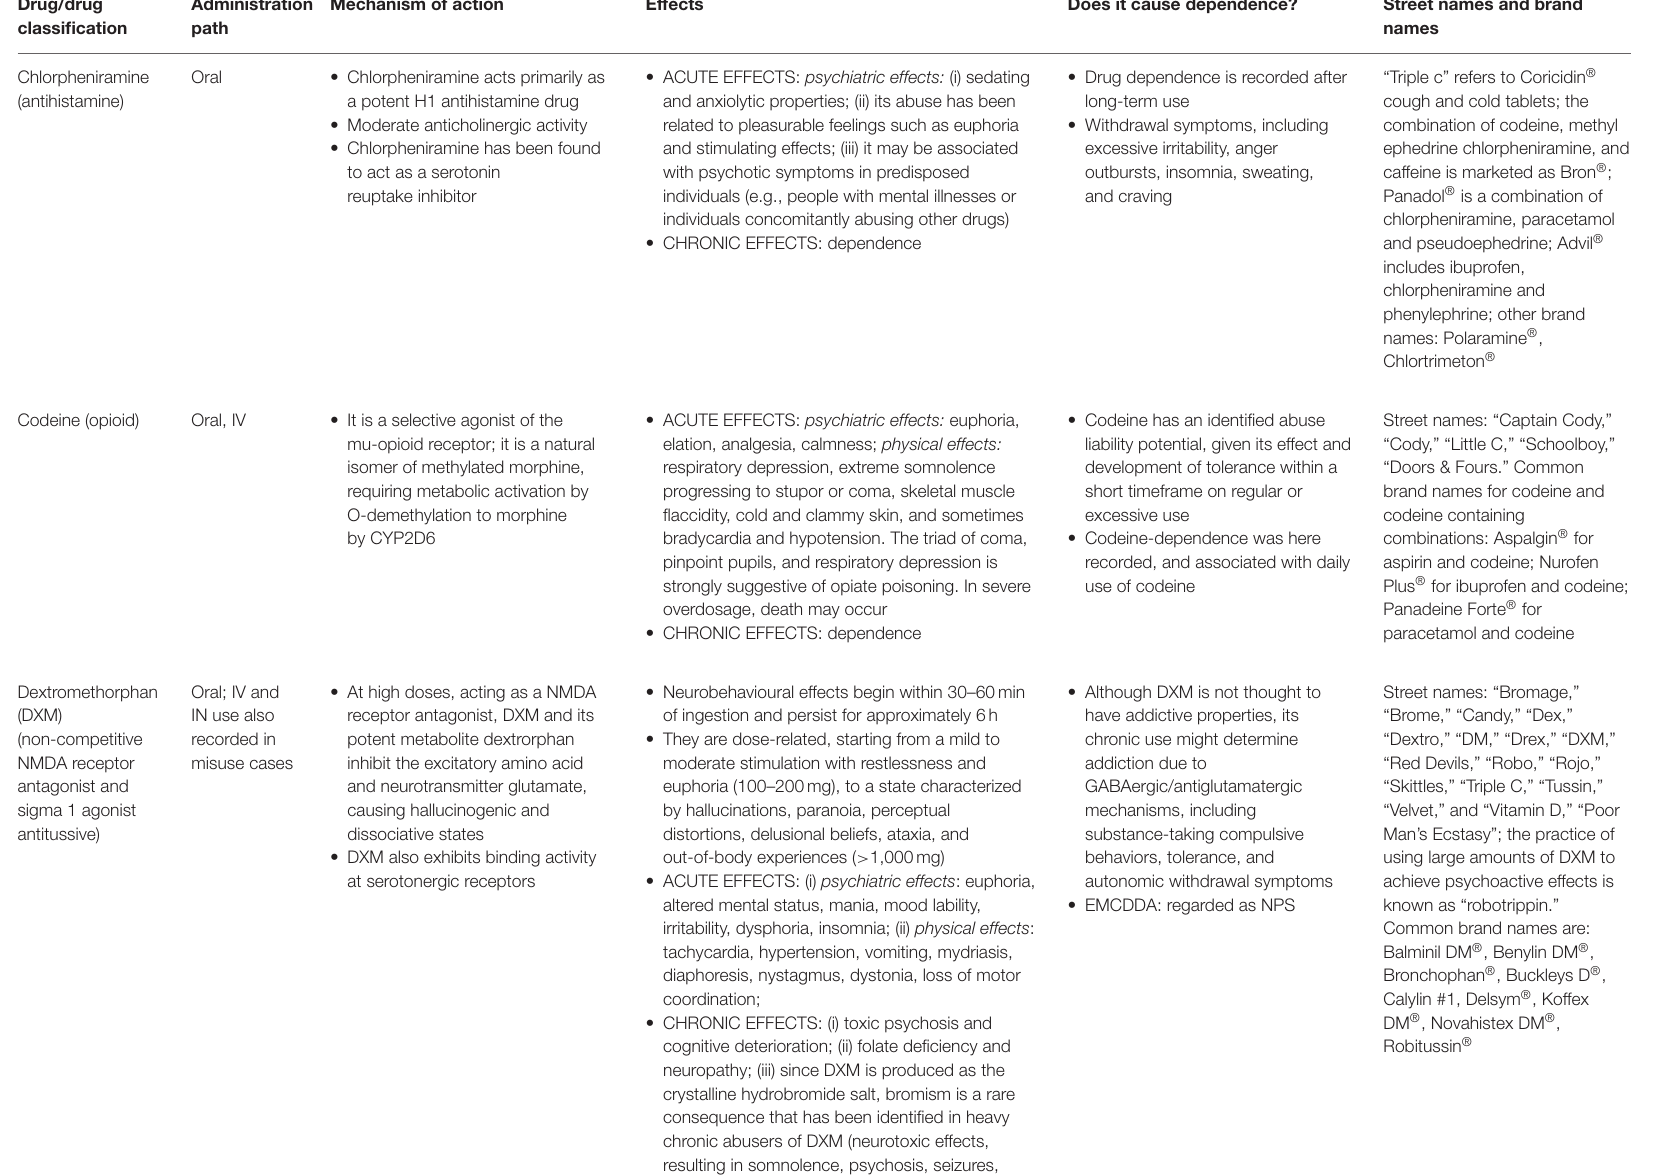
TABLE 1 | Drug classification and main characteristics of misuse of the selected OTC drugs. Drug/drug